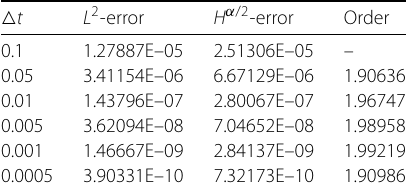
Table 2 The L 2 and H α /2 numerical errors at α = 1.5 for various temporal resolutions v